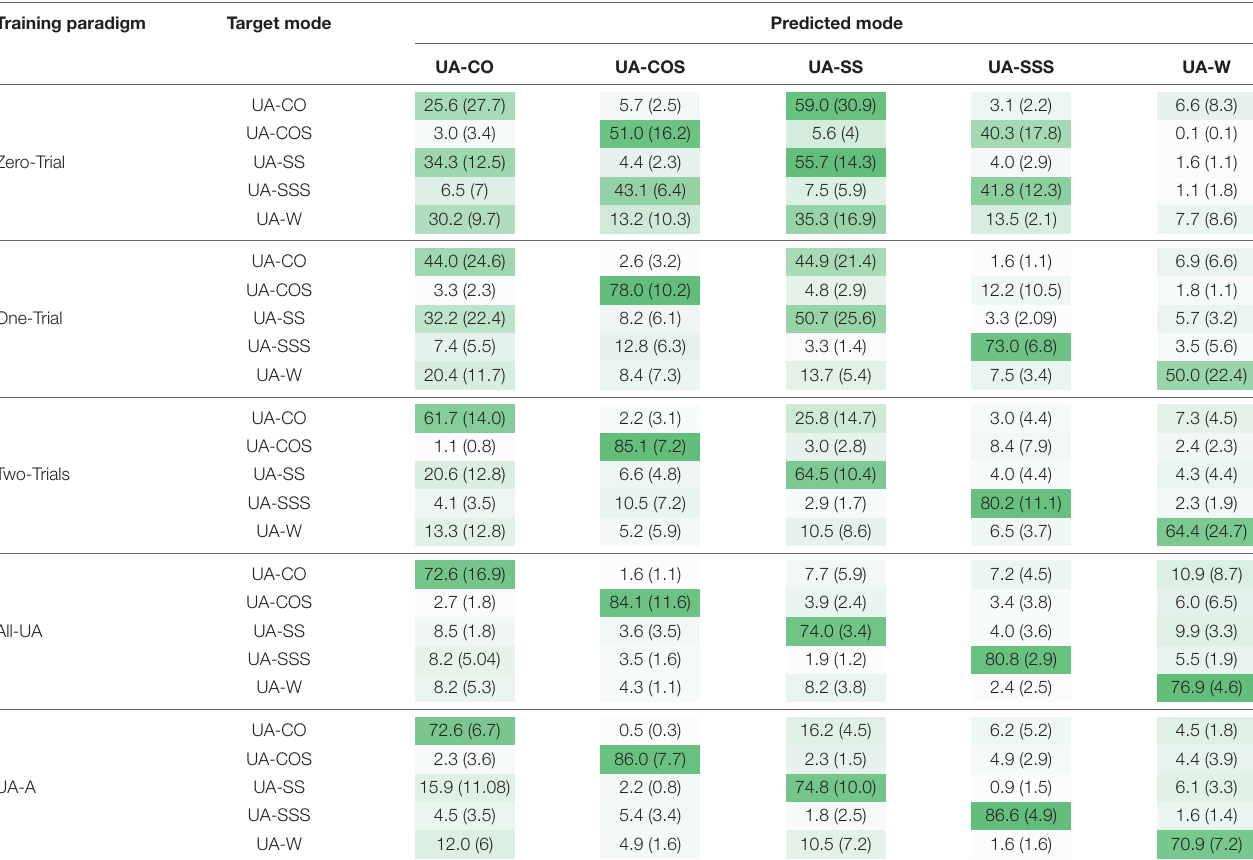
TABLE 2 | Confusion matrices for unanticipated locomotor tasks using varying training paradigms. Training